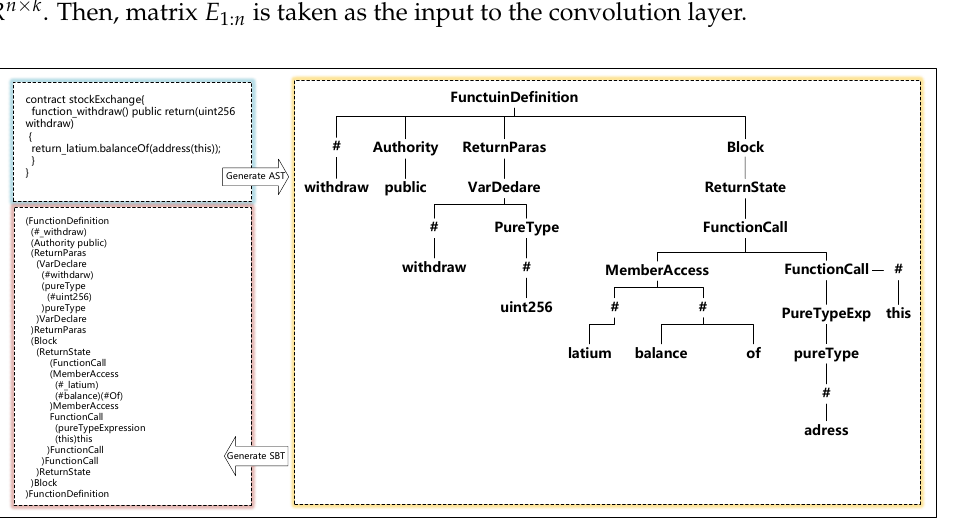
Figure 3. The SBT